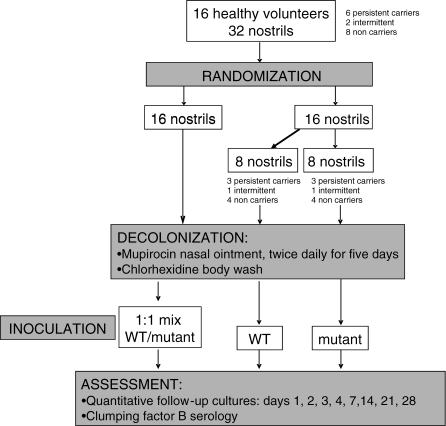
Study DesignFirst, the left or right nostril was randomized to receive the inoculation mix, containing strains 8325-4 (WT) and DU5997 (mutant strain). Second, the contralateral nostril was randomized to receive either the naturally occurring (“WT” in figure) or mutant strain.